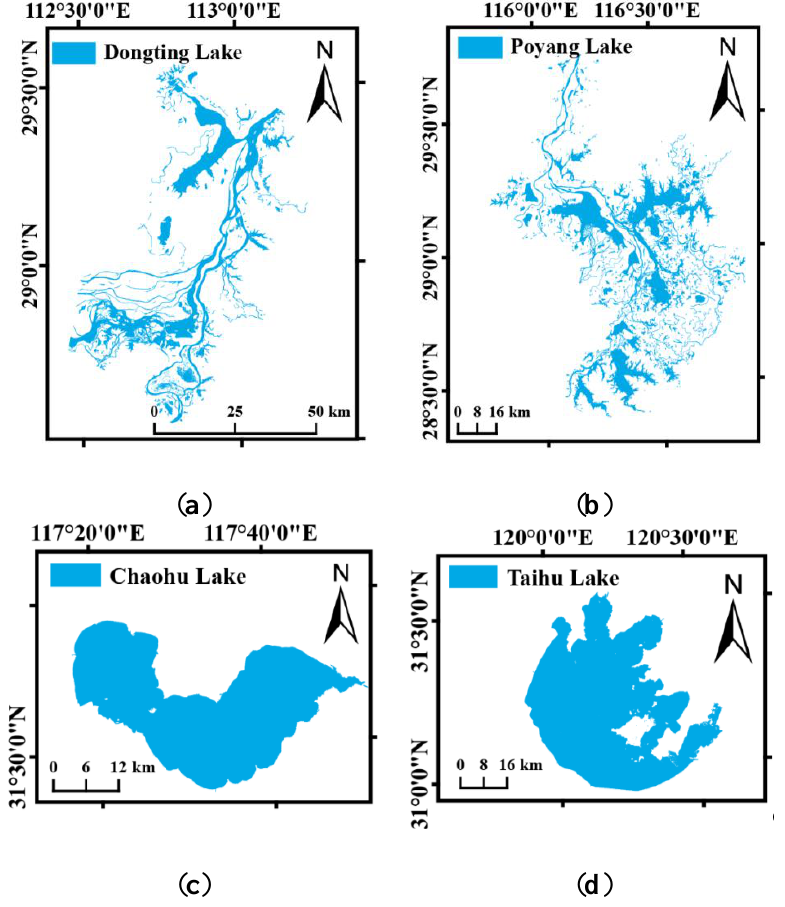
Figure 2. Extraction examples of ( a ) Dongting Lake; ( b ) Poyang Lake; ( c ) Chaohu Lake, and ( d ) Taihu